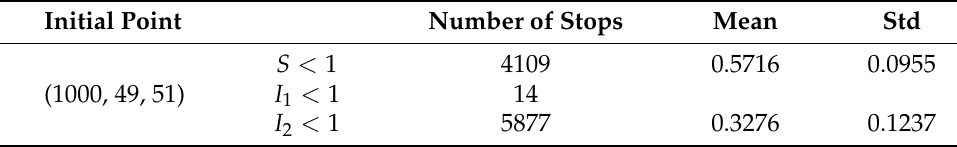
Figure 3. Example 2, vertical transmission of both strains: S ( 0 ) = 1000. Table 4. Example 2: Euler–Maruyama